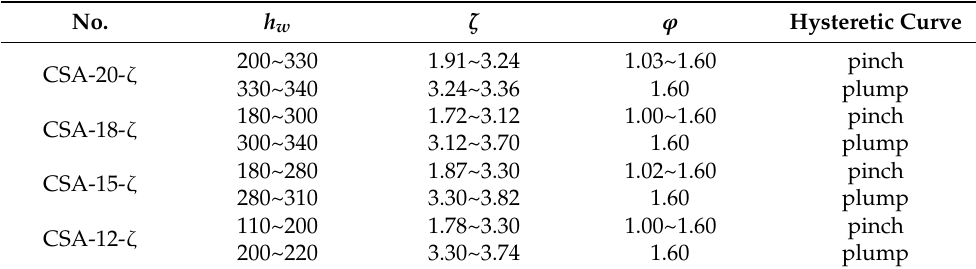
Table 4. Results of hysteretic load protocol of CSA-BRB specimens.